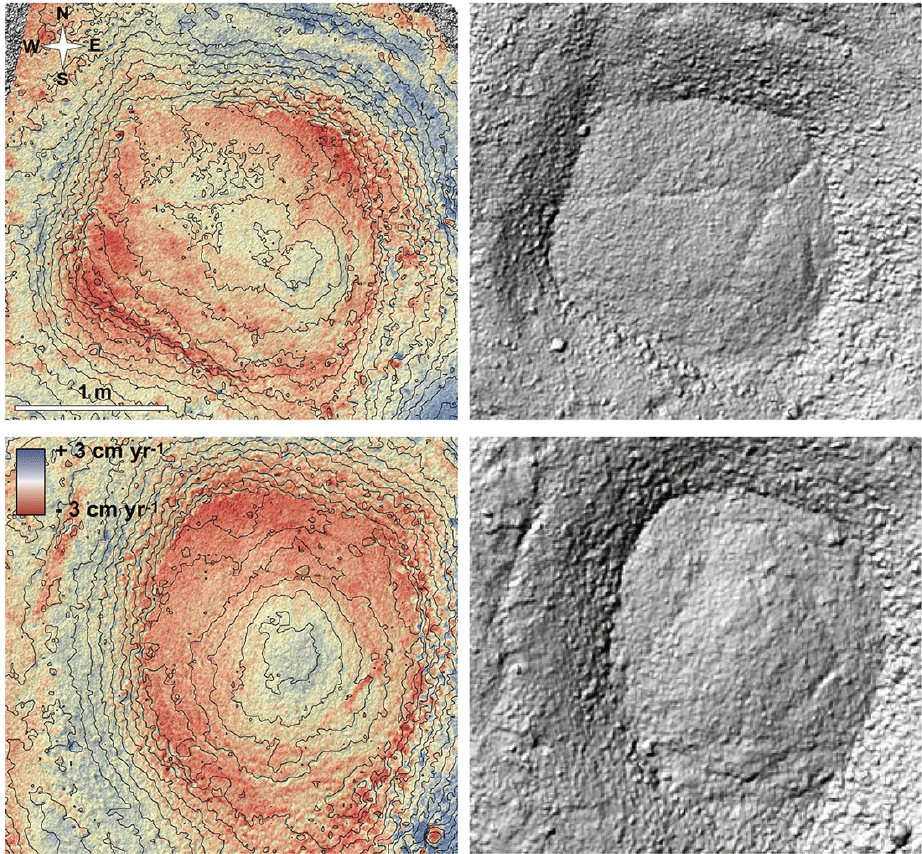
Figure 7. Left: elevation change 2010–2007 on the northern (top) and middle circle (bottom). Two-centimetre contour lines are indicated in black. Right: hillshades of 2cm resolution DEM of 2007. The highest parts of the fine domains coincide well with the largest rates of relative surface heave in the fine domain, and the deepest parts with the strongest surface lowering. Note that the horizontal plane of zero elevation change is uncertain due to insufficient absolute georeference; therefore the elevation changes can be interpreted as relative changes in microrelief